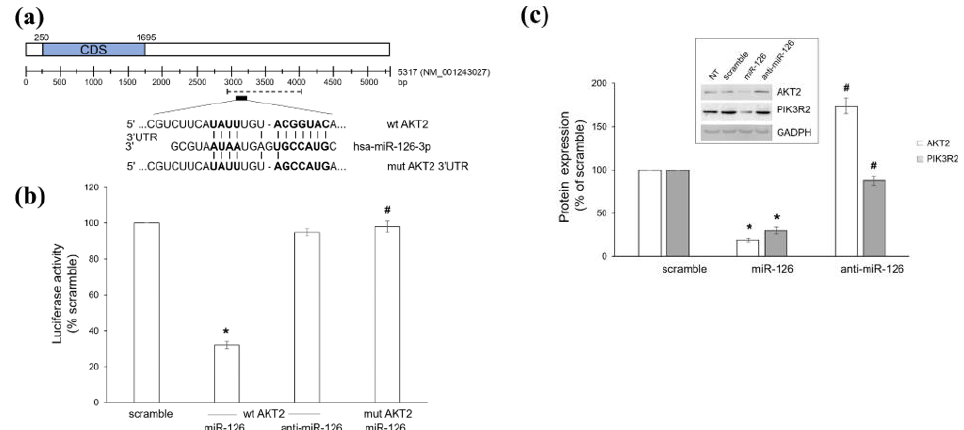
Figure 1. Ectopic miR-126-3p downregulates AKT2. ( a ) Predicted miR-126-3p target site on AKT2 3 (cid:48) UTR, as recognized by TargetScan Human 8.0 software. The sequence of wild type (wt) and mutant (mut) AKT2 3 (cid:48) UTR is shown; bold letters indicate the miR-126-3p seed sequence. Region cloned into the pGL3-Control Luciferase Reporter Vector is also indicated (dashed line). ( b ) Dual luciferase assay of wild type (wt) and mutated (mut) AKT2 3 (cid:48) UTR after transfection with scramble oligo (scramble), miR-126-3p-mimic (miR-126), or inhibitor (anti-miR-126). Values are reported as percentage of scramble-transfected cells, arbitrarily set to 100%. Results are shown as mean ± S.E.M. of four different measures from three independent experiments. * p < 0.01 versus scramble, # p < 0.01 versus wt AKT2 3 (cid:48) UTR. ( c ) Western blot of AKT2 and PIK3R2 in BT549 cells left untreated (NT) or transfected with either scramble oligo (scramble) or miR-126-3p mimic (miR-126) or inhibitor (anti- miR-126). Values are reported as percentage of scramble-transfected cells (not statistically differing from NT cells), arbitrarily set to 100%. Blots are representative of five independent experiments and results are shown as mean ± S.E.M. * p < 0.01 versus scramble, # p < 0.01 versus